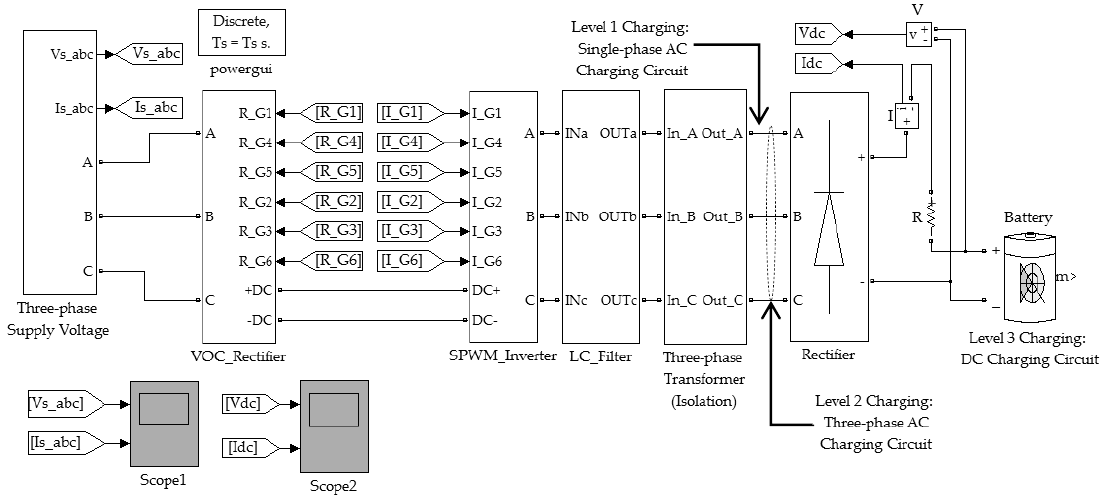
Figure 6. Overall simulation model for the proposed universal battery charger.